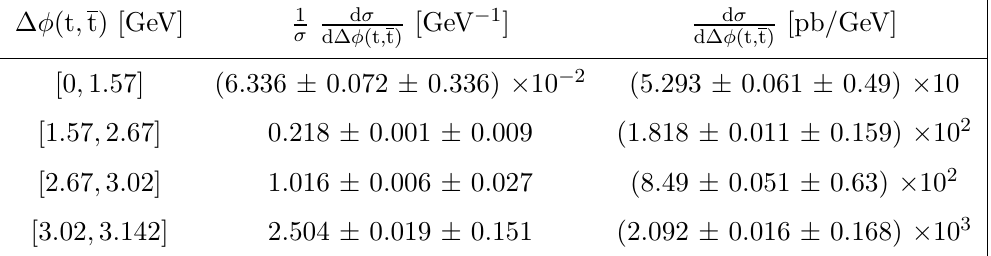
Table 14 . The measured di(cid:11)erential cross section and bin boundaries for each bin of the normalized and absolute measurements of the tt di(cid:11)erential cross section at parton level in the full phase space as a function of (cid:1) (cid:30) (t ; t) are